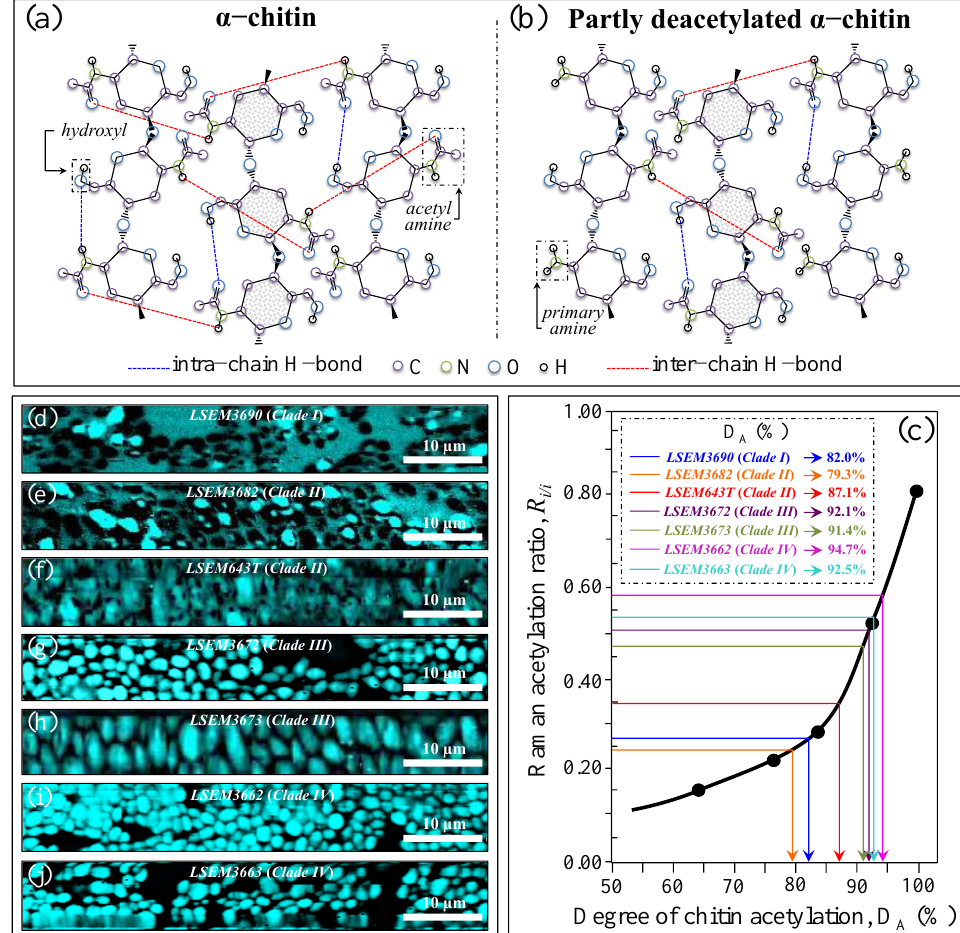
Figure 8. Molecular structure of ( a ) α– chitin and ( b ) partly deacetylated α– chitin (with their charac- teristic hydrogen bonds and molecular units); ( c ) Raman calibration plot of the R i/i = I 1644 / I 1660 intensity ratio vs. degree of chitin acetylation, D A (data from data in Ref. [51]); ( d – j ): Raman images of the R i/i ratio collected on different C. auris samples (cf. labels). The average R i/i value for each image locates the respective D A value on the calibration plot ( c ) (cf. values shown in inset given in %).